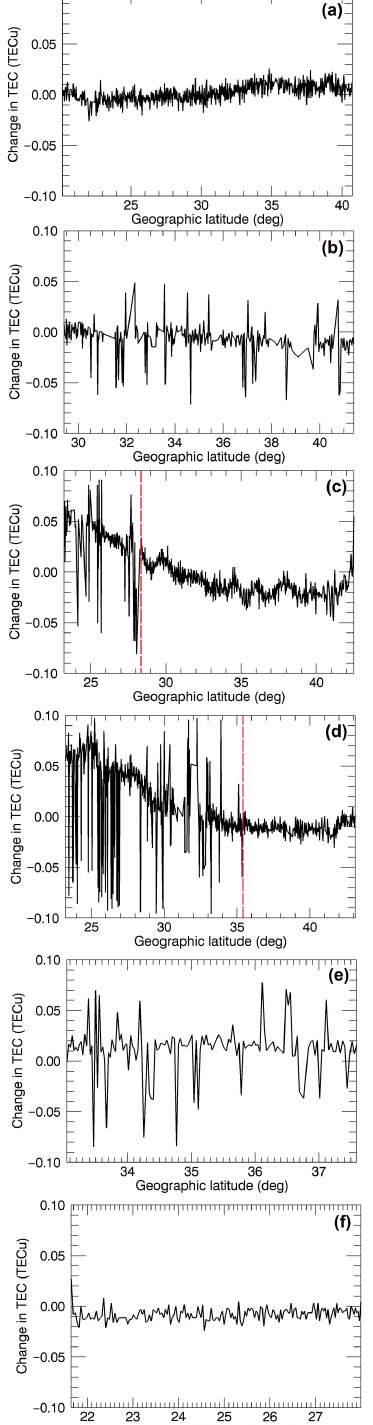
Figure 4. (cid:49) TEC/ (cid:49)t versus geographic latitude of the F region in- tercept. The passage time corresponds to the same panels (alphabet- ically sequenced) in Fig. 2. The vertical red dashed lines show the disturbance upper limits during the main phase of the magnetar’s